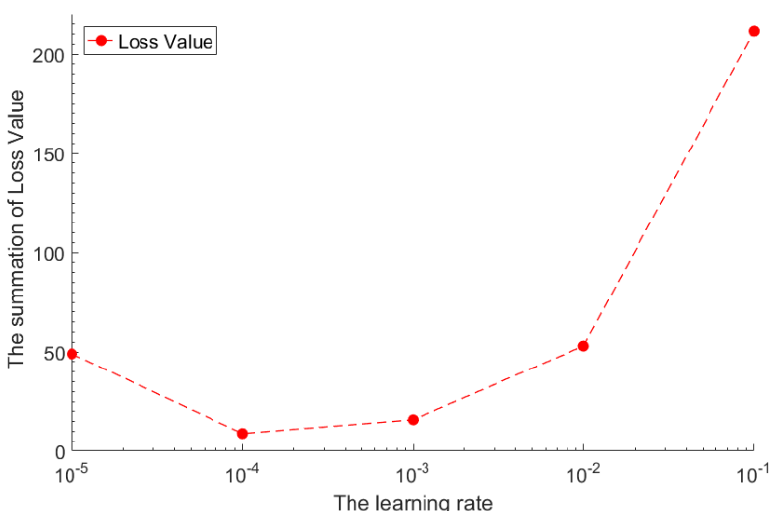
Figure 5. The loss value of model with different learning rates.